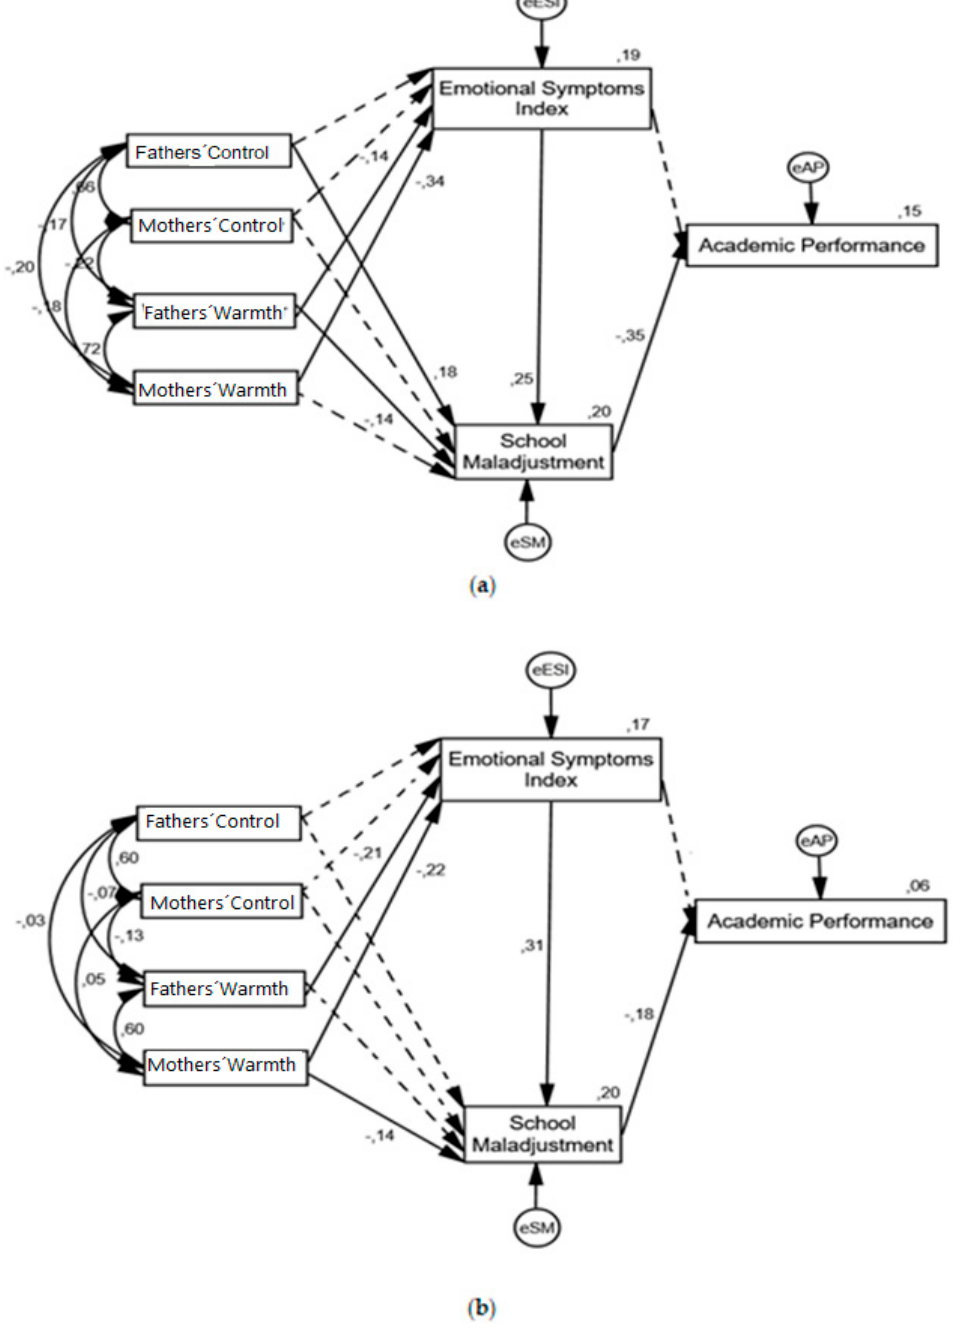
Figure 1. Standardized solution of the explanatory structural model (dashed lines indicate statistically non-significant relationships): ( a ) Males’ model; ( b ) Females’ model.